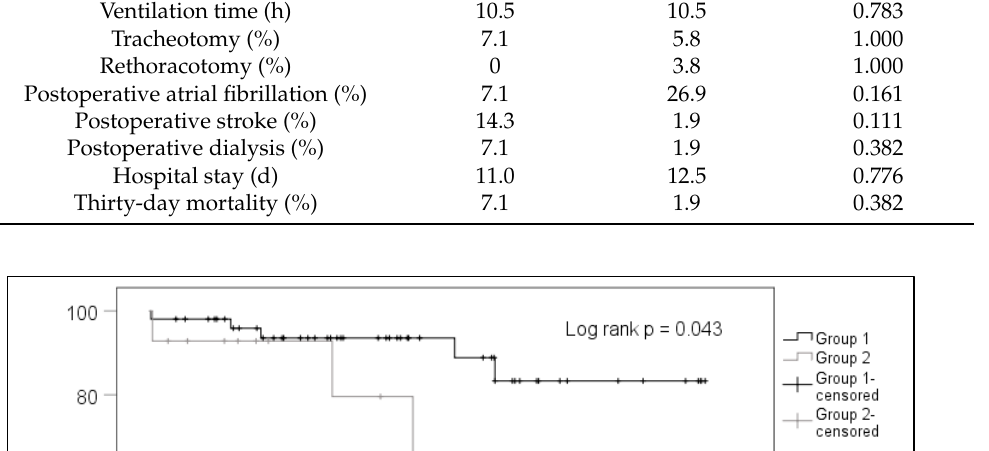
Table 8. Follow-up.